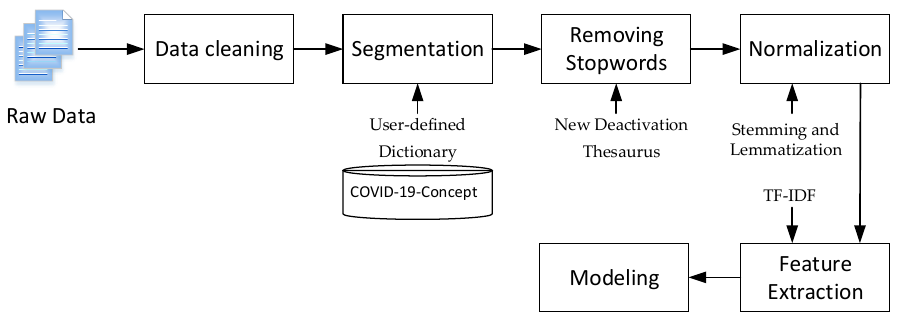
Figure 2. The process of text data preprocessing and optimization methods.